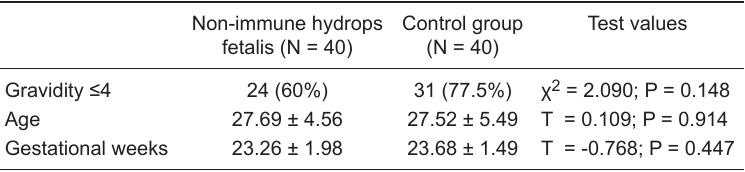
Table 1. Demographic and clinical characteristics of the mothers of fetuses with non- immune hydrops fetalis and